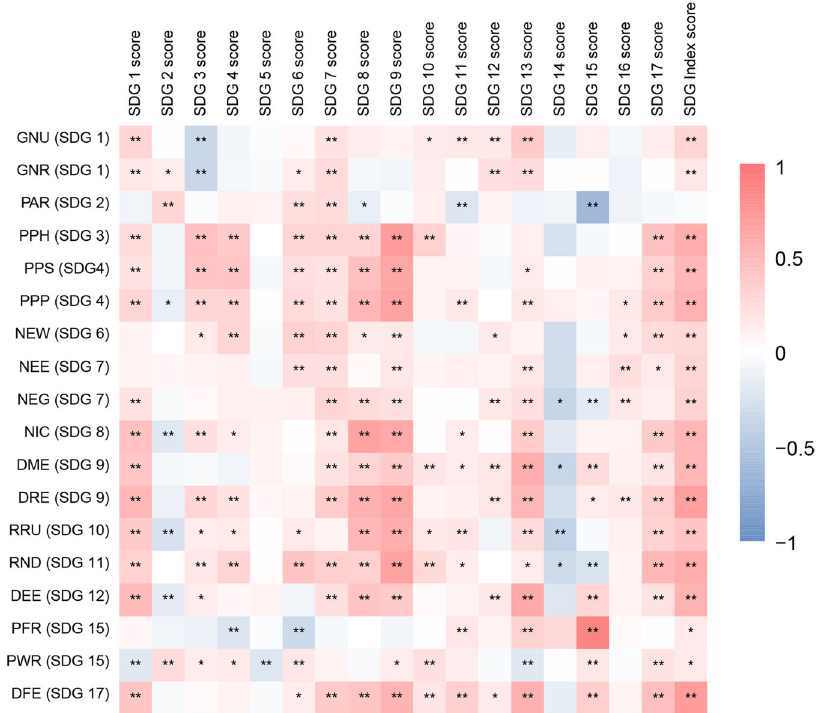
Fig. 2 Correlations of individual SDG scores with big data monitoring indicators. Each cell colour represents its Pearson correlation coef fi cient. * and ** denote the 0.05 and 0.01 signi fi cance levels, respectively. The SDG Index score and 17 individual scores were calculated using statistical data, and the sample included 254 cities, as in the previous section. For details on the acronyms of these big data monitoring indicators, see Table